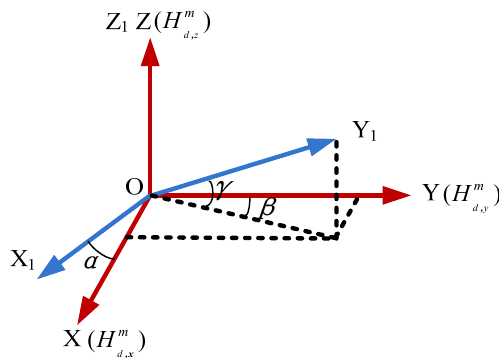
Figure 1. Non-orthogonal angles of magnetometers.